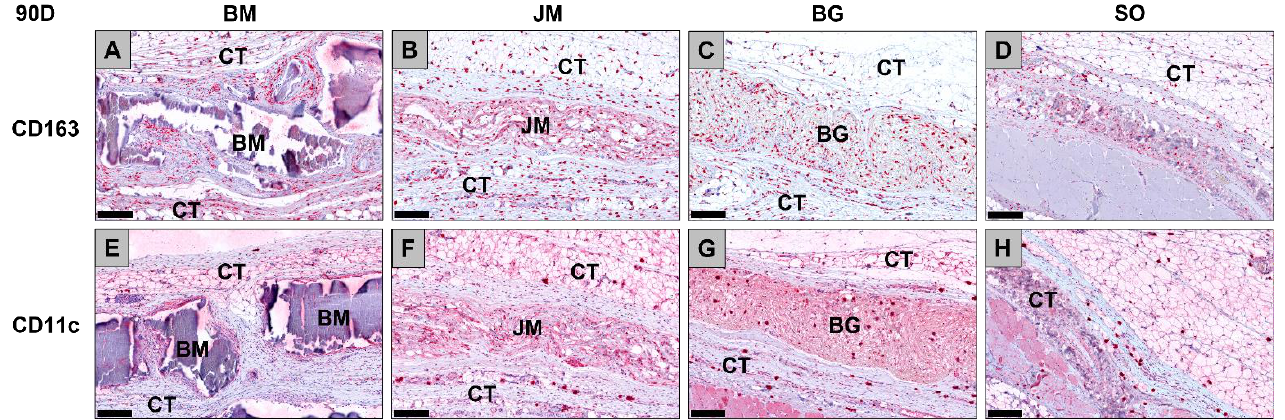
Figure 11. Exemplary histological images of the distribution of anti-inflammatory CD163-positive macrophages ( A – D ) and pro-inflammatory CD11c-positive macrophages ( E – H ) (red staining) within the implant beds of the three membranes within the subcutaneous connective tissue (CT) at day 90 post implantationem. ( A ) BM = Bovine membrane, ( B ) JM = Jason ® membrane, ( C ) BG = Bio-Gide ® membrane, ( D ) Sham operation group without biomaterial insertion (CD163-immunostainings ( A – D ) and CD11c-immunostainings ( E – H ), 200× magnifications, scalebars = 200 µm).